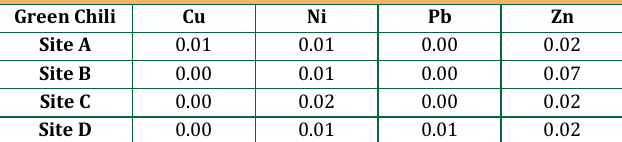
Table 2: Daily Intake of metals (kg/person/day)